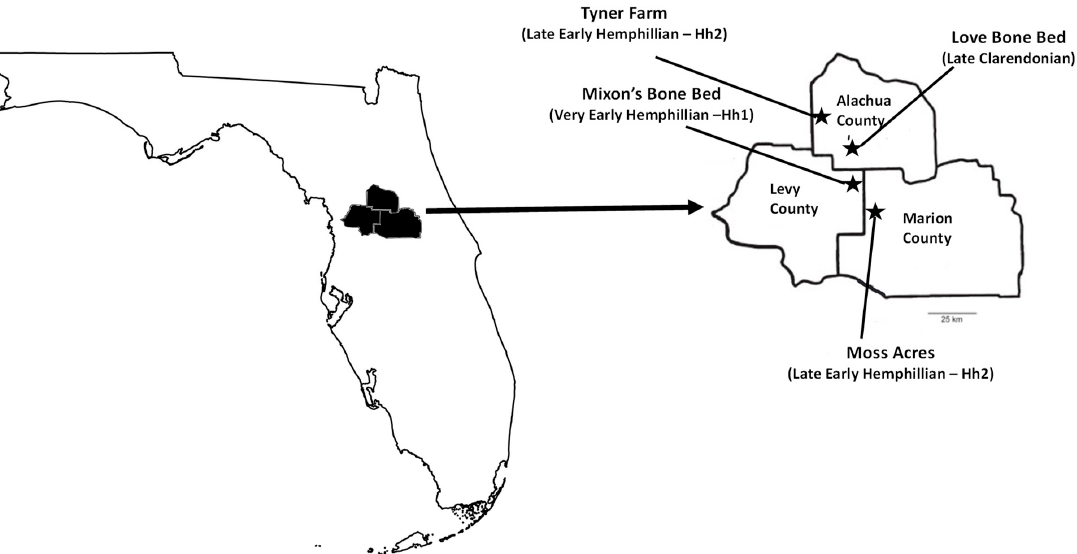
Figure 2. Fossil Localities . Clarendonian and Hemphillian fossil localities in Florida where shovel- tuskers were found (Modified Figure 1 from [21]; Map modified from GIS Geography.com/florida- county-map/, accessed on 25 May 2022.).